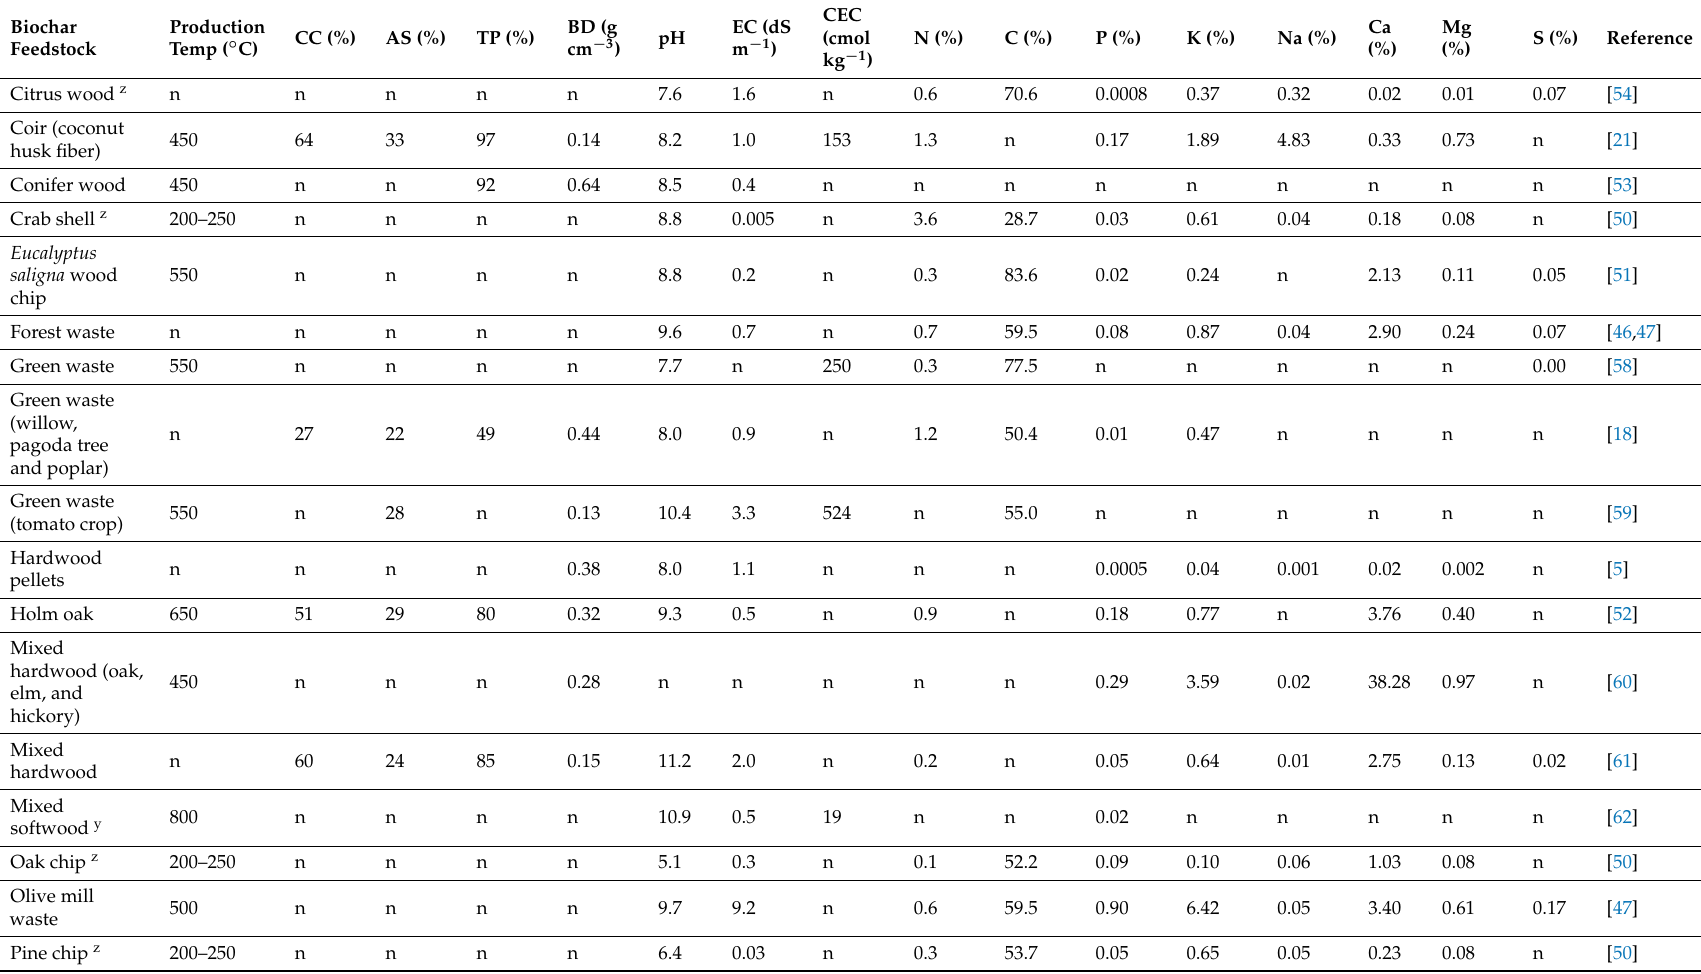
Table 1. Summary of the feedstock, production condition and properties of the biochars used in container